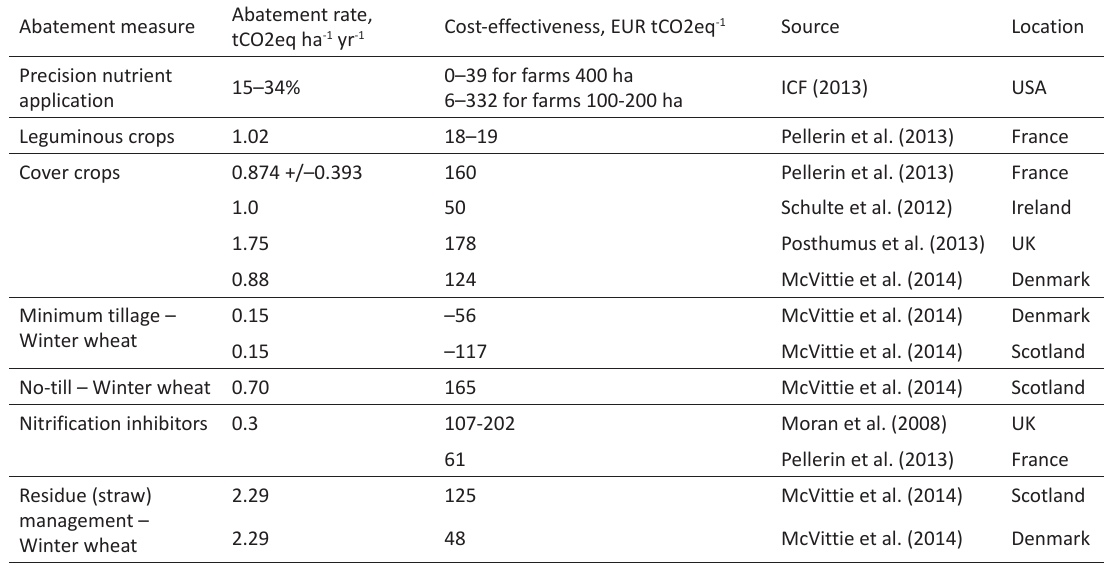
Table 3. Cost-effectiveness of measures related to crop production Abatement